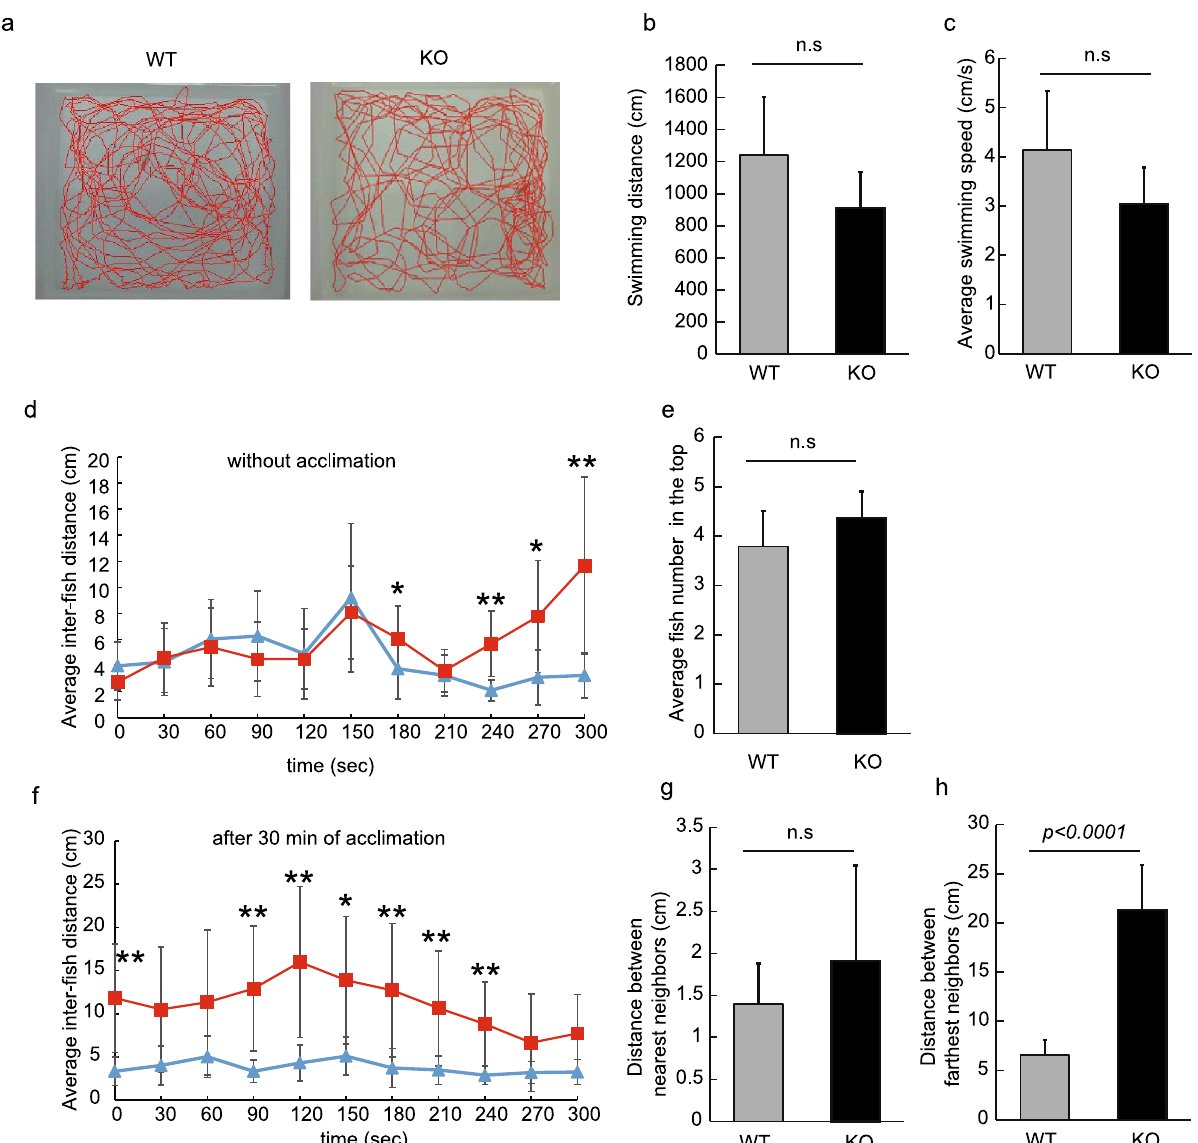
Figure 1. Analysis of shoaling in Neu1-KO and WT zebrafish. ( a – c ) Analysis of the behavior of Neu1-KO zebrafish (6 months) in the normal tank for 5 min. ( a ) Tracking. ( b ) Swimming distance. ( c ) Average swimming speed. WT, wild-type and KO, Neu1-KO zebrafish. n = 7 for each group. ( d – h ) Shoaling of Neu1-KO zebrafish. Five fish were set in the experimental tank, and their average inter-fish distance was immediately estimated ( d , without acclimation) . After 30 min acclimation in the test tank, inter-fish distances were evaluated again ( f , with acclimation). Closed blue triangles and red squares with single line indicate WT and KO, respectively. ( e ) Average fish number in the top area for 5 min. ( g ) Average distance between nearest and ( h ) farthest neighbors analyzed for 5 min in WT and Neu1-KO zebrafish during the shoaling test without acclimation. Results are shown as means ± standard deviation. All values were compared using Mann–Whitney U test. * p < 0.05, ** p < 0.01. n.s., not zebrafish to evaluate their emotional responses. As a result, we found that the swimming behaviors of Neu1- KO zebrafish were drastically different from those of WT zebrafish. Both WT and Neu1-KO zebrafish showed an interaction with the mirror (towards the opponent in the mirror), but Neu1-KO zebrafish were noted to approach the mirror more than WT zebrafish (Fig. 3b), despite exhibiting a similar total swimming distance to that of WT (Fig. 3c). This result indicated that the increased interaction observed in Neu1-KO zebrafish might not be due to hyperactivity or impulsive behavior. We also observed that Neu1-KO zebrafish exhibited a signifi- cant increase in the total time in the approach area (2.4-times longer than WT, p < 0.01, Fig. 3d). However, the total entry into the approach area in Neu1-KO zebrafish was shown to be less than that in WT ( p < 0.01, Fig. 3e), indicating that Neu1-KO zebrafish stayed for a longer period in the approach area in a single invasion compared with WT zebrafish. After approaching the mirror, the zebrafish showed a chasing behavior towards the opponent